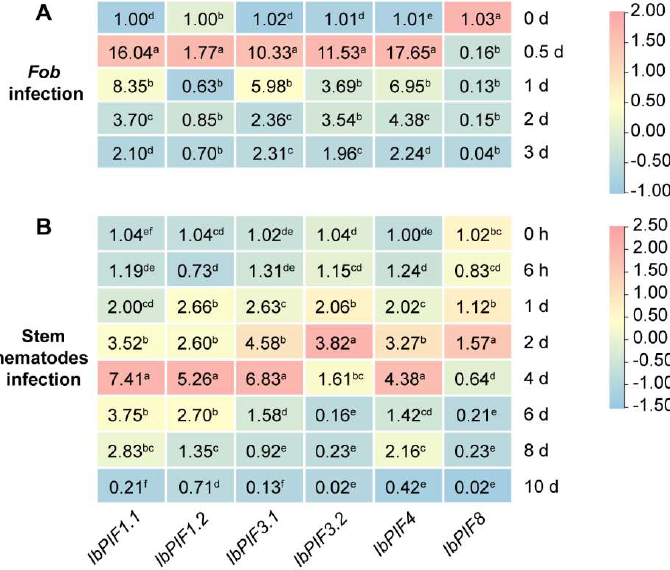
Figure 9. Gene expression patterns of IbPIFs of I. batatas in response to biotic stresses: ( A ) Fob infec- tion; and ( B ) stem nematode infection. The values were determined by qRT-PCR from three biolog- ical replicates consisting of pools of three plants, and the results were analyzed using the compara- tive C T method. The expression at 0 h in each treatment was considered “1”. The fold change is shown in the boxes. Different lowercase letters indicate a significant difference of each IbPIFs at p < 0.05 based on Student’s t